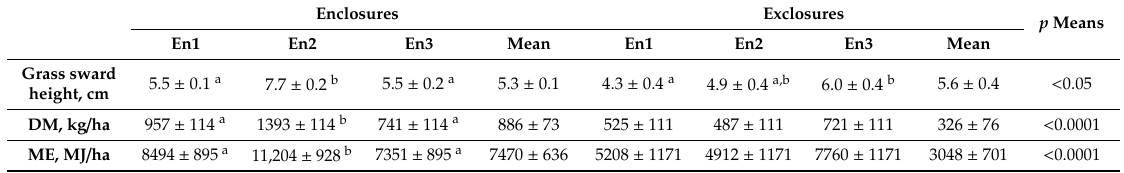
Table 3. Mean grass sward height and content of dry matter (DM) and metabolizable energy (ME) in the enclosures grazed by horses and in the exclosures within each enclosure mown monthly from May 2014 to September 2016. Exclosures were mown at the same spots as sward height measurements were